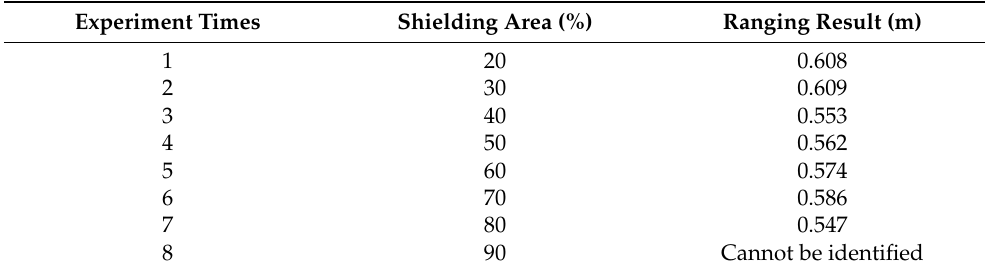
Table 5. Different shade area range